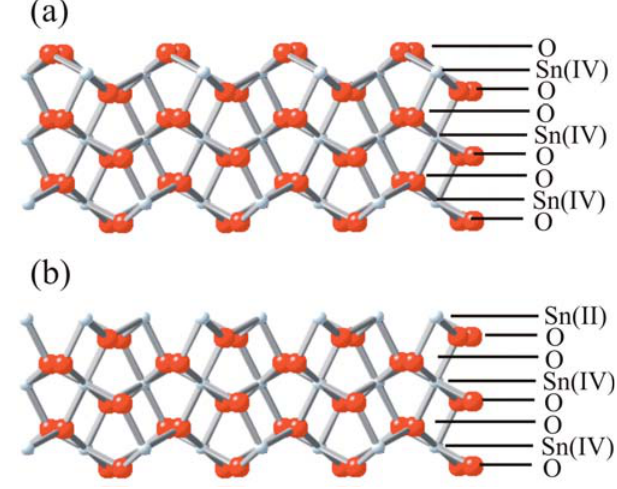
Figure 6 . Ball-and-stick model of a cross-sectional view through a SnO orientation. The (101) surface is at the top. (a) Stoichiomtric bulk truncation with O termination. (b) reduced surface with Sn termination. In (b) surface Sn-atoms adopt a valency of II.